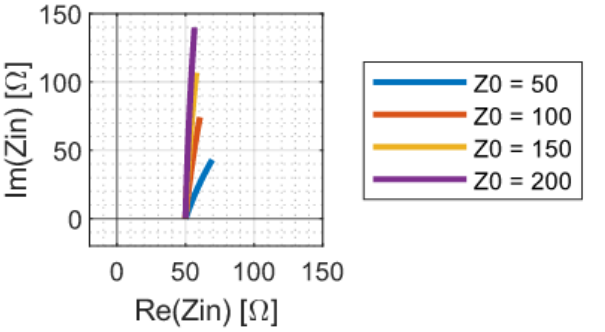
Figure 8. Nyquist plot of the link input impedance as the length of the transmission line between L 12 and L 21 increases from 0 to 0.5 m. The various traces correspond to different characteristic transmission line impedances. The transmission line used in the simulation has a wave propagation speed of 0.6 c and is terminated in a 50 Ω load.